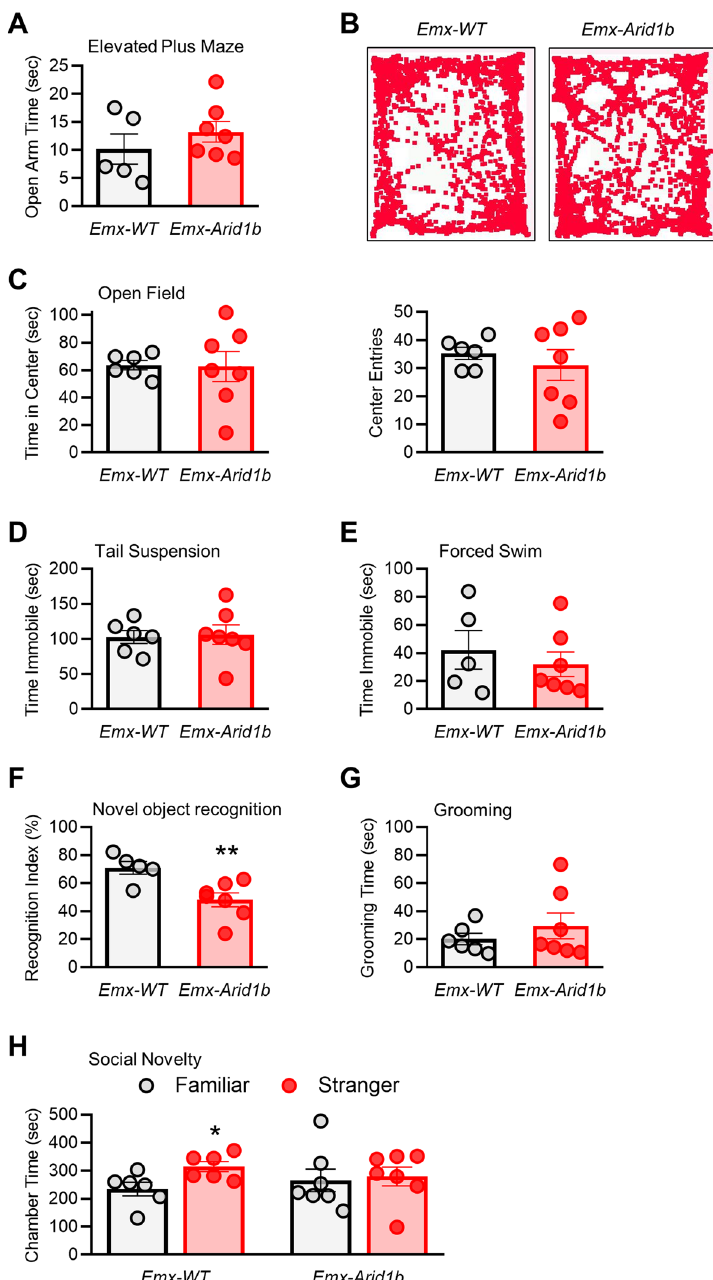
Figure 7. Effects of conditional deletion of Arid1b in cortical neural progenitors on behavior. ( A ) In the elevated plus maze, Emx-Arid1b mice spend the same amount of time in the open arm as controls. N = 6 mice for control and N = 7 mice for Emx-Arid1b . Statistical significance was determined by two-tailed Student’s t test. Error bars show SEM. ( B ) No significant difference in immobility times in the tail suspension test between controls and Emx-Arid1b mice. N = 6 mice for control and N = 7 mice for Emx-Arid1b . Statistical significance was determined by two-tailed Student’s t test. Error bars show SEM. ( C ) In the forced swim test there was no significant difference in immobility time between control and Emx-Arid1b . N = 6 mice for control and N = 7 mice for Emx-Arid1b . Statistical significance was determined by two-tailed Student’s t test. Error bars show SEM. ( D ) Representative traces from ( E ). ( E ) No significant difference in the total time spent in the center or the number of entries into the center in the open field test. N = 6 mice for control and N = 7 mice for Emx-Arid1b . Statistical significance was determined by two-tailed Student’s t test. Error bars show SEM. ( F ) No significant change in grooming time in a 10-min session between control and Emx-Arid1b mice. N = 6 mice for control and N = 7 mice for Emx-Arid1b . Statistical significance was determined by two-tailed Student’s t test. Error bars show SEM. ( G ) Emx-Arid1b mice demonstrate impaired novel object recognition. Recognition index indicates the percentage of time the test mouse interacted with a novel object compared to a familiar one. N = 5 mice for control and N = 7 mice for Emx-Arid1b . Statistical significance was determined by two-tailed Student’s t test. Error bars show SEM. ( H ) Social behavior in Emx-Arid1b mice was tested by the three-chamber social assay. N = 6 mice for control and N = 7 mice for Emx-Arid1b . Statistical significance was determined by two-tailed Student’s t test. Error bars show SEM. * p < 0.05, ** p <